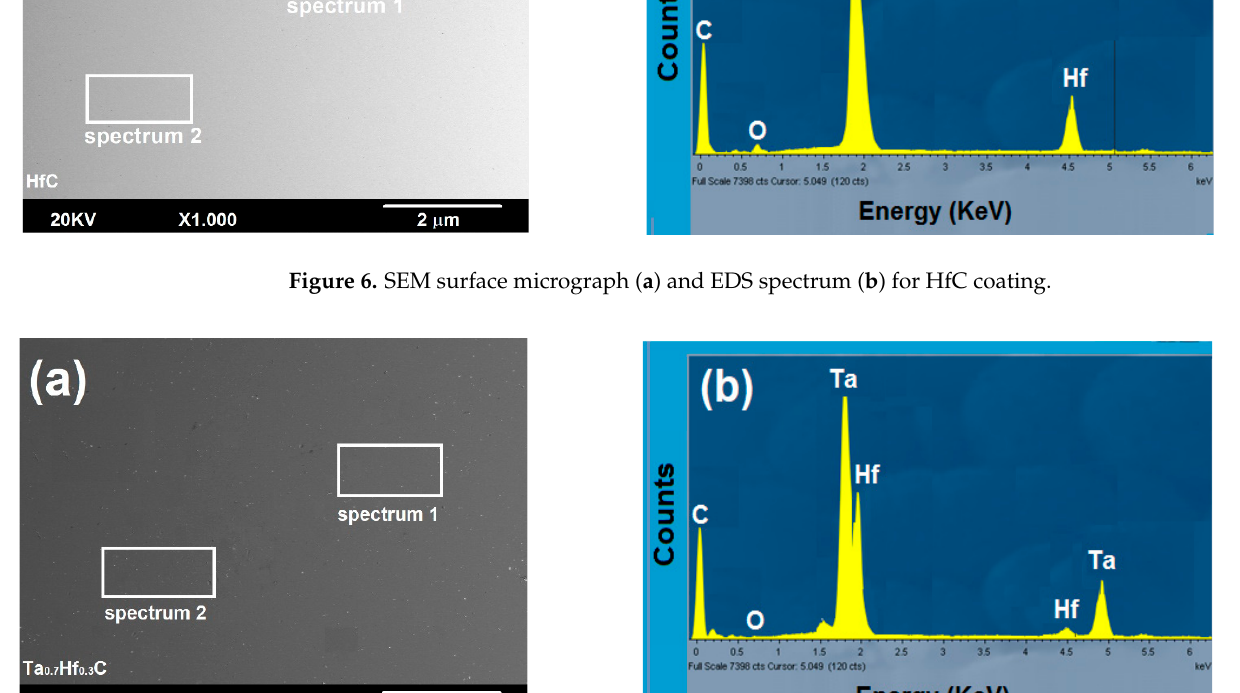
Figure 7. SEM surface micrograph ( a ) and EDS spectrum ( b ) for Ta 70 -Hf 30 -C coating.